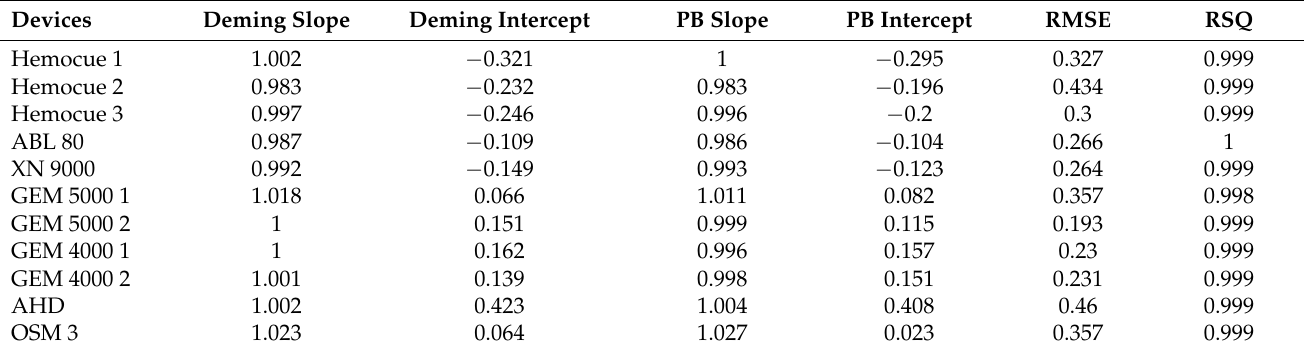
Table 3. Quality criteria for the test devices. Regression analysis of Deming and Passing–Bablok = PB, RMSE = root mean square error, RSQ = R